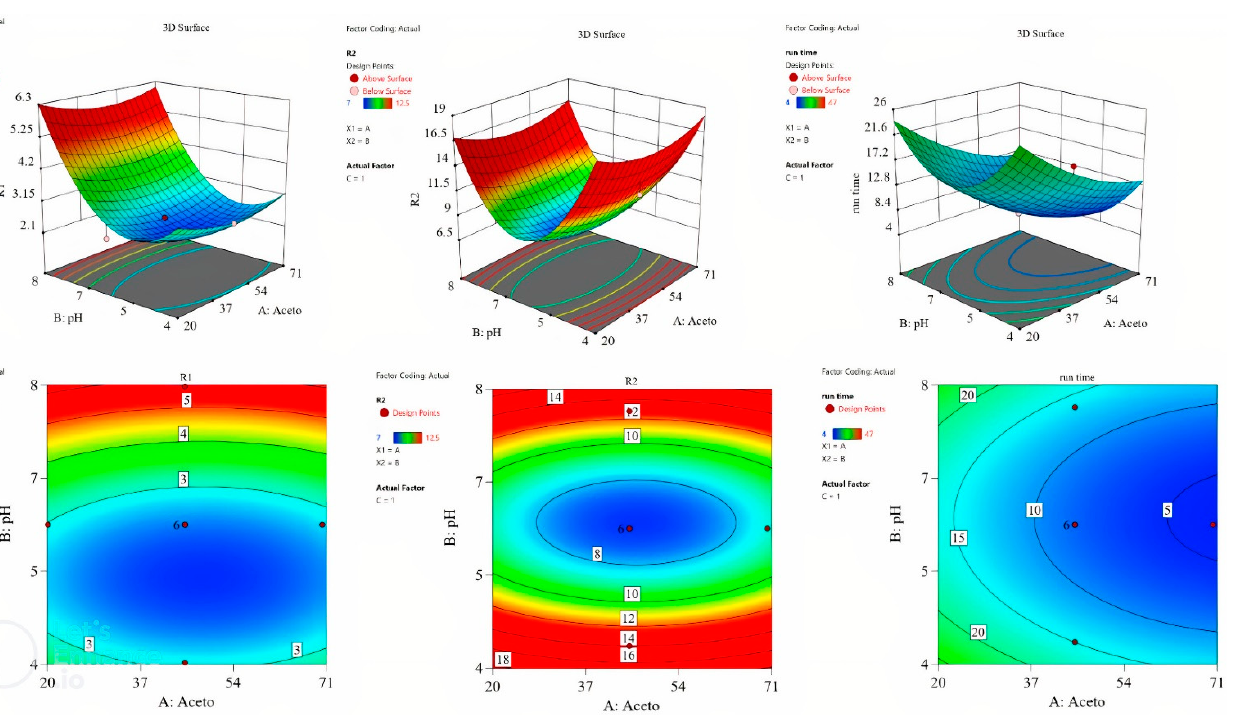
Figure 3 . Overlay plot of the responses for the interaction of two factors, showing the sweet spot colored in yellow .